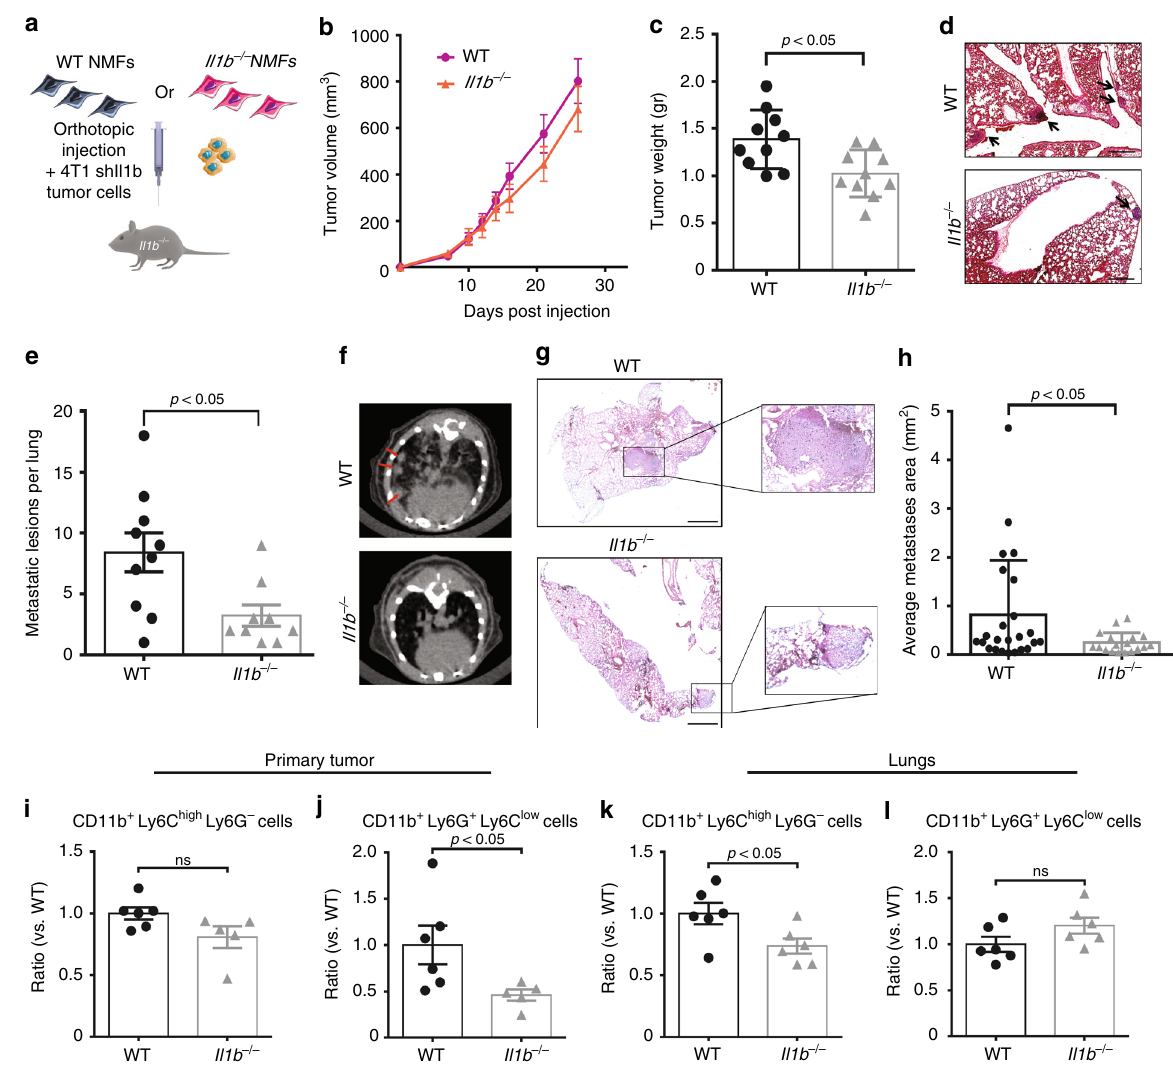
Fig. 5 CAF-derived IL-1 β facilitates lung metastasis. a Scheme of experiments analysed in b – e . shIl1b 4T1 mammary carcinoma cells were orthotopically co- injected with WT NMFs ( Il1b + / + ) or with Il1b − / − NMFs into the right inguinal mammary glands of Il1b − / − female mice. b Growth curves of 4T1 tumours injected with WT NMFs ( Il1b + / + ) or with Il1b − / − NMFs. n = 10 mice per group. c Tumour weight at termination of experiment. n = 10 mice per group. d Representative H&E staining of lung sections from injected mice. Insets depict spontaneous metastases (arrows). e Quanti fi cation of metastatic lesions per lung (serial sections of whole lungs were analysed). n = 9 and 10 individual mice per group (WT and Il1b − / − , respectively). Data are representative of three independent experiments. f – h BALB/c female mice were orthotopically injected with shIl1b 4T1 cancer cells admixed with WT NMFs ( Il1b + / + ) or with Il1b − / − NMFs. f Micro-CT intravital imaging of lungs shows spontaneous macrometastases (arrows). g H&E staining of lung tissue sections showing metastatic nodules. Insets depict enlarged fi elds of spontaneous metastases. h Quanti fi cation of metastatic load performed by analysing the area